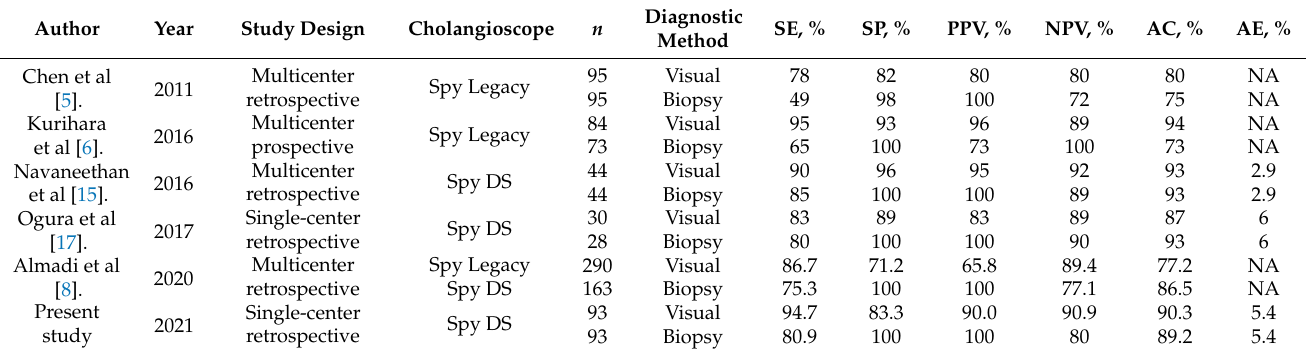
Table 8. Summary of studies on the characteristics and outcomes of diagnostic procedures by POCS.